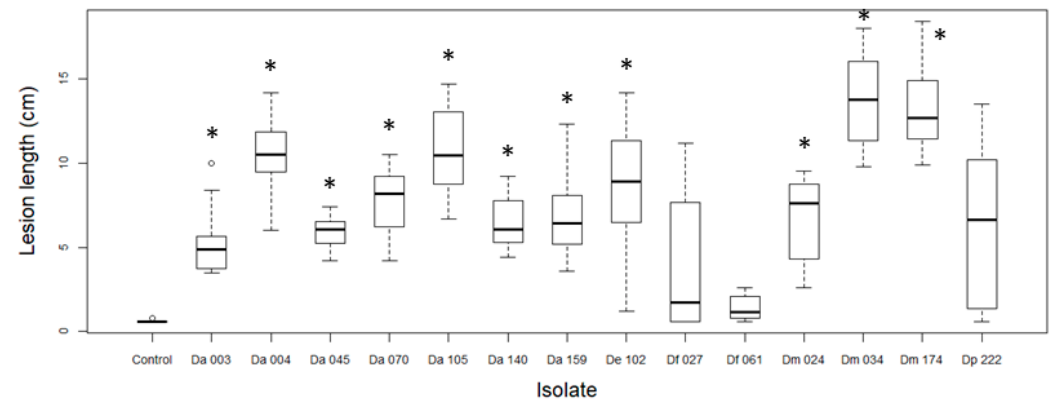
Figure 5. Box plot of lesion length (cm) caused by isolates of Diaporthe spp. on almond detached twigs (n = 12 per isolate) at 15 days after inoculation. Black lines in the boxes show medians. Isolate labels: Da: D. amygdali , De: D. eres , Df: D. foeniculina , Dp: D. phaseolorum , Dm: D. mediterranea. Asterisks (*) indicate that values are significantly different from the control according to the Wilcoxon rank sum test ( p < 0.01).